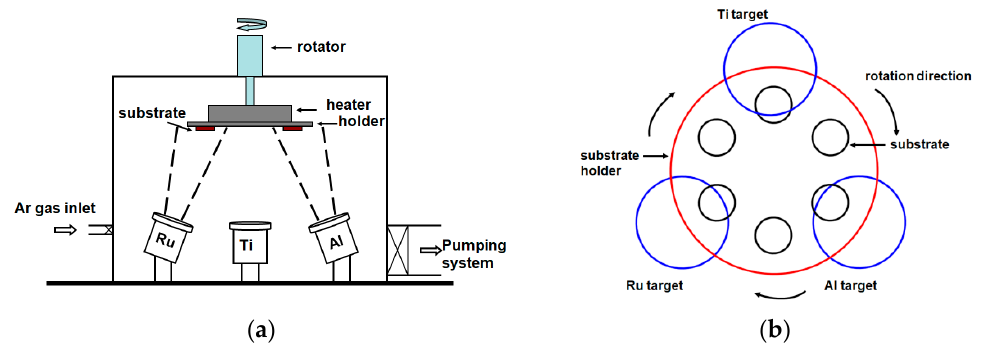
Figure 1. ( a ) Schematic of the cosputtering equipment and ( b ) substrate holder and sample positions related to sputter targets.